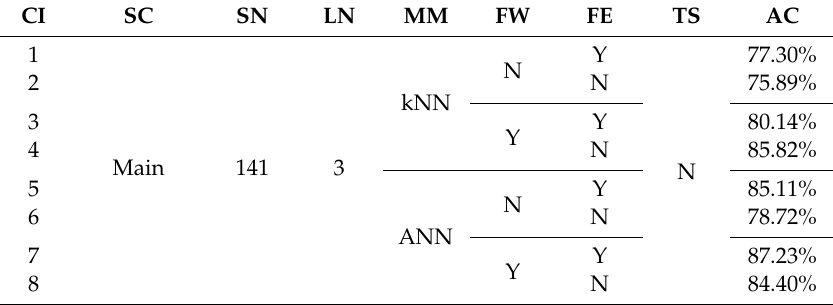
Table 4. Results. CI: case identifier; SC: class set; SN: number of samples used; LN: number of the labels applied for indicating the classification output; MM: adopted machine learning method; either artificial neural network (ANN) or k-nearest neighbors (kNN); FE: whether or not the feature